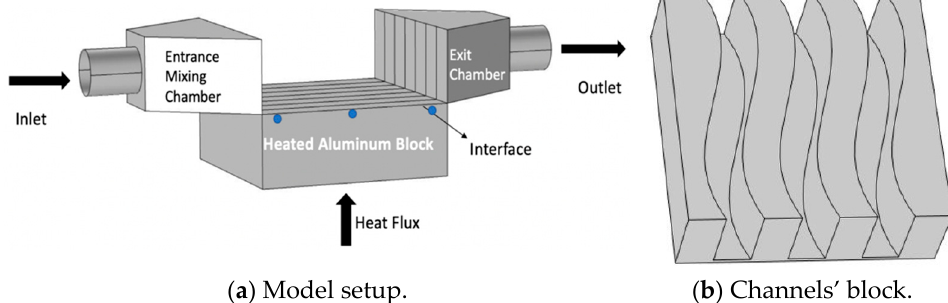
Figure 1. ( a ) Model setup. ( b ) Channels’ block.